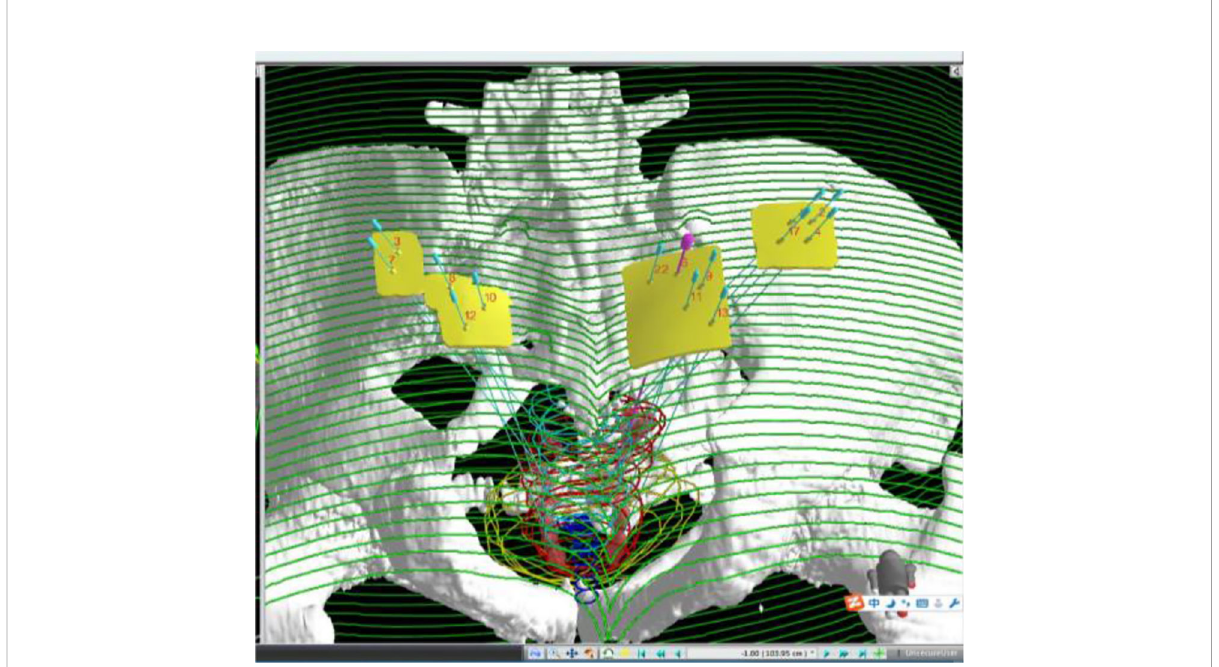
FIGURE 1 Three-dimensional reconstruction of targets, organs at risk, needle channels, and templates on